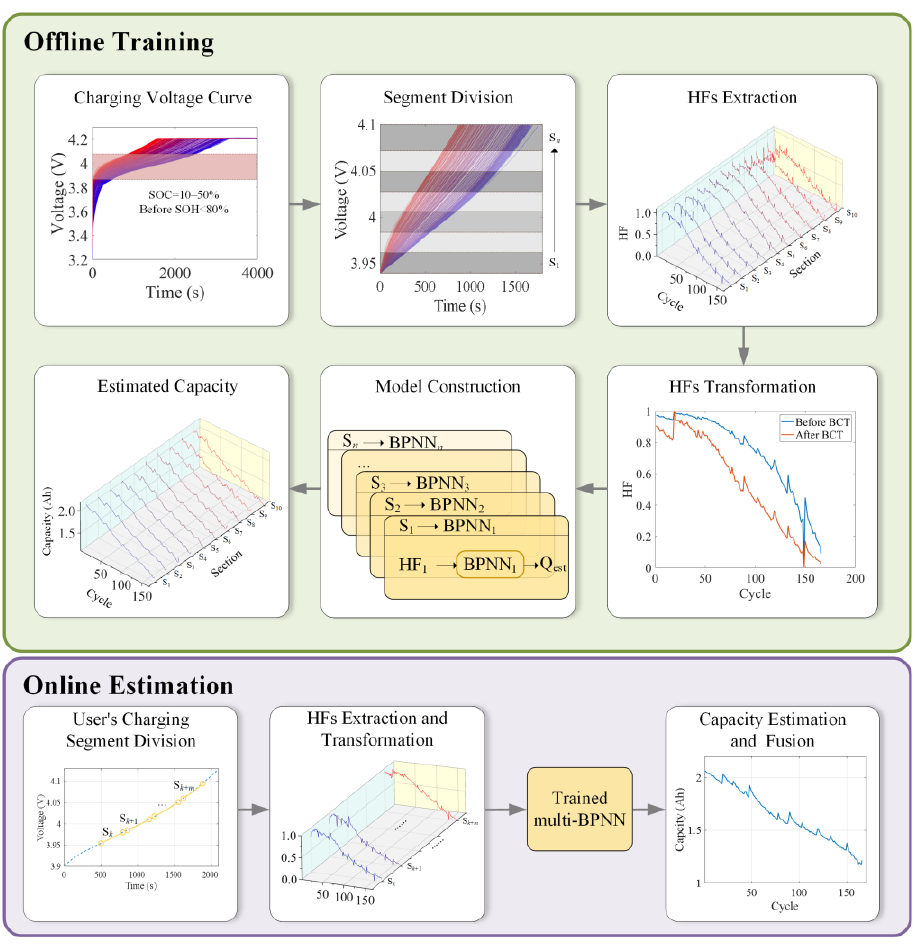
Figure 4. The flowchart of the proposed method.